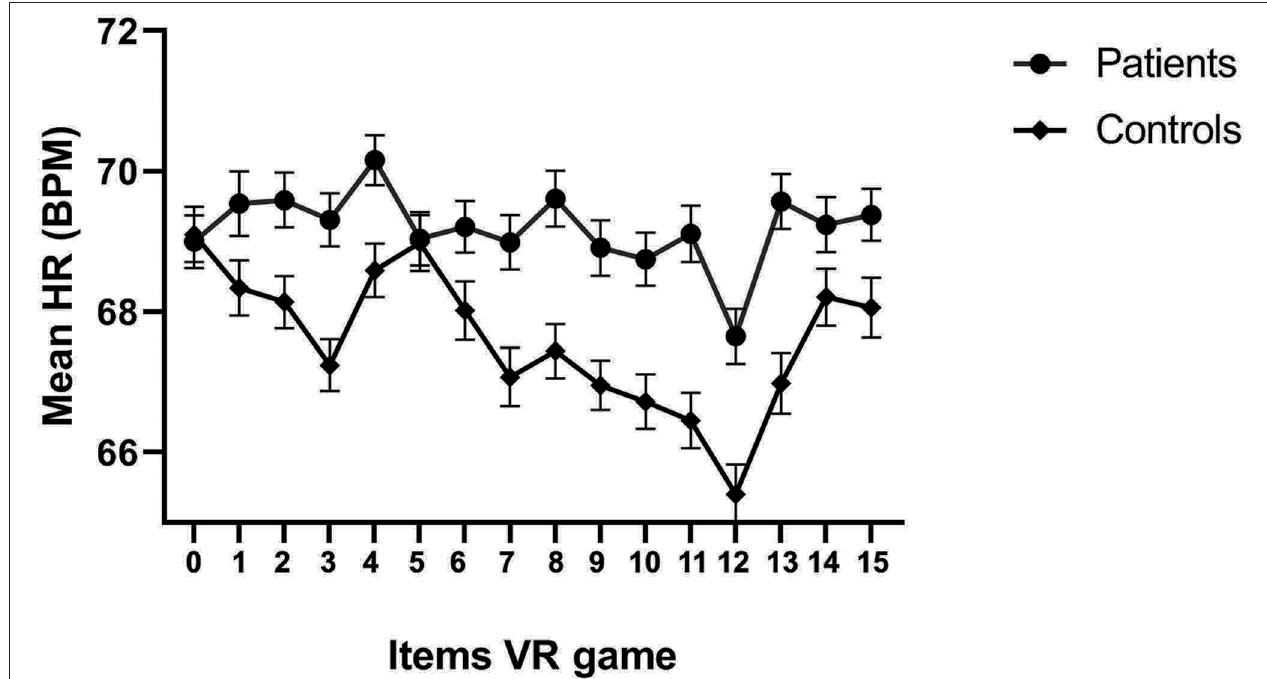
FIGURE 3 | Mean heart rate and SE per